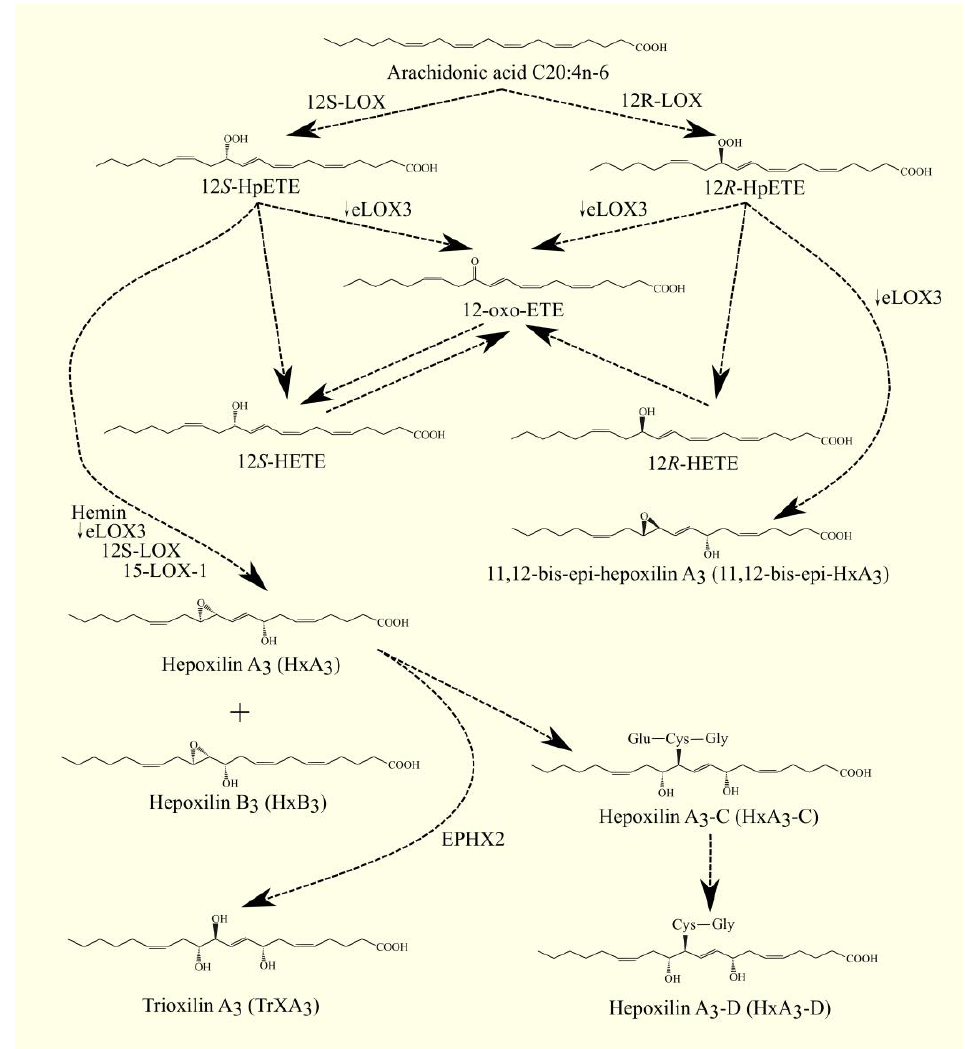
Figure 5. 12-LOX pathway. ARA C20:4n-6 is converted to 12 S -HpETE and 12 R -HpETE with 12S-LOX and 12R-LOX, respectively. Either 12-oxo-ETE or the corresponding 12-HETE can be formed from these compounds. 12 S -HpETE can also be converted to HxA 3 or HxB 3 with hemin and lipoxygenases: eLOX3, 12S-LOX, or 15-LOX-1. 12 R -HpETE can undergo a similar conversion to 11,12-bis-epi-HxA 3 . HxA 3 may undergo further transformations. HxA 3 can be conjugated to glutathione. HxA 3 -C is then formed, from which amino acids can be detached — HxA 3 -D is then formed in a reaction similar to the transformation of cysteinyl-leukotrienes. HxA 3 can also be converted to TrXA 3 . Arrows next to enzymes: higher or lower expression of given enzymes in GBM tumor relative to healthy tissue. ↓ — lower expression of given enzymes in GBM tumor relative to healthy tissue.